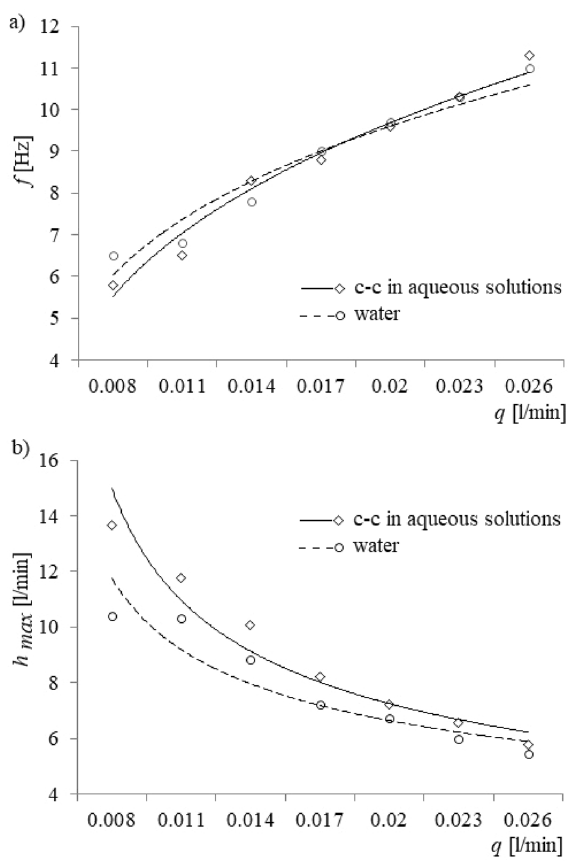
Figure 4. Frequencies of bubble departures and maximum depth of liquid penetration into the capillary vs. air volume flow rate. ( a ) Frequencies of bubble departures, ( b ) depth of liquid penetration into the